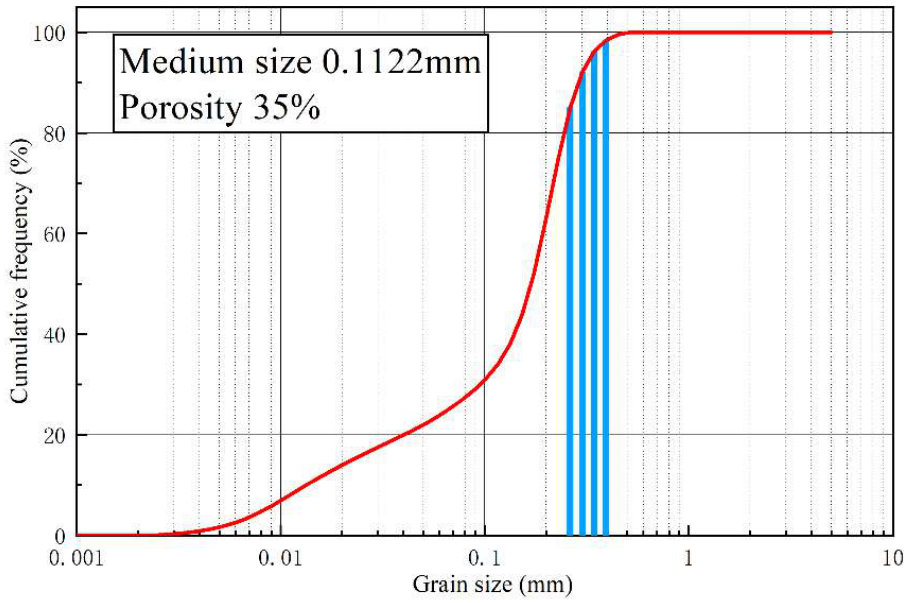
Figure 4. Grain size distribution of natural sand.